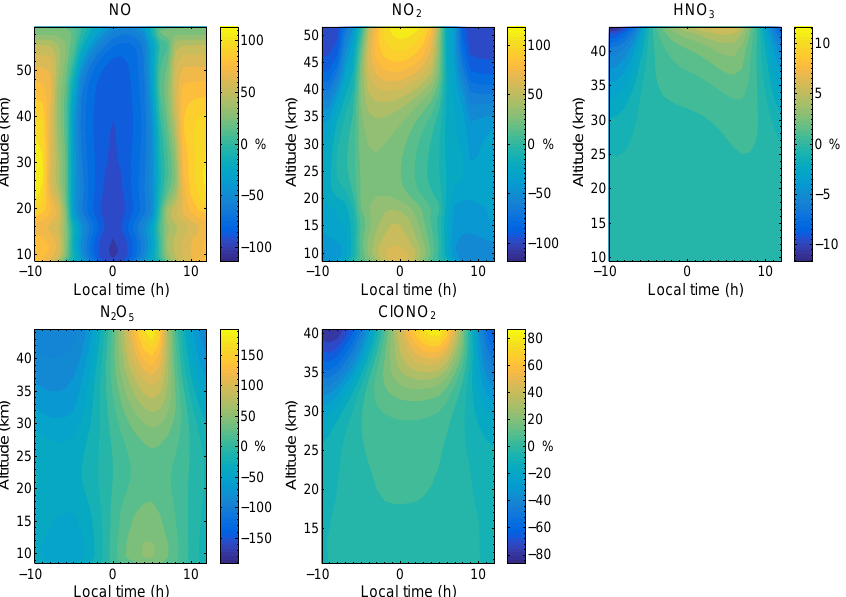
Figure 1. Diurnal variation in percent for NO, NO 2 , HNO 3 , N 2 O 5 , and ClONO 2 profiles, calculated by the Pratmo model for all ACE-FTS v3.5 data. At each altitude, variation is the percent deviation from the mean VMR at that altitude.